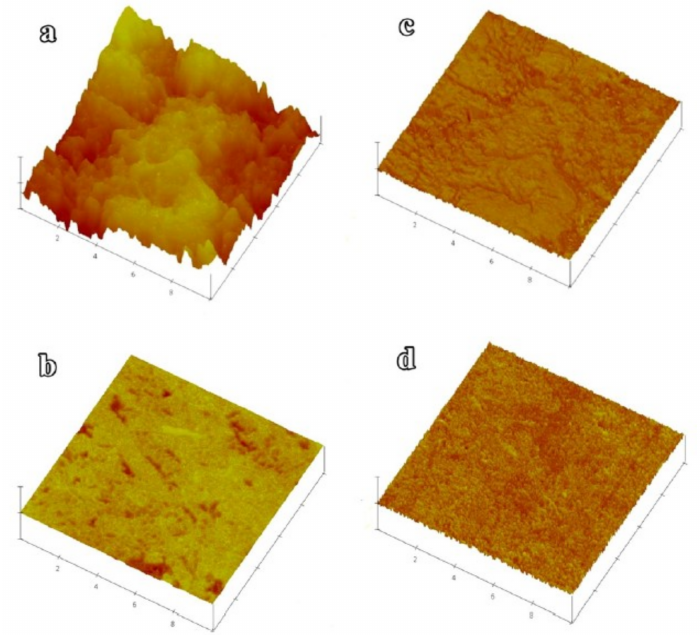
Figure 14. Atomic force microscope images of ( a ) height image of the conventional cement paste, ( b ) height image of the cement paste mixed with nano-TiO 2 , ( c ) phase image of the conventional cement paste, ( d ) phase image of the cement paste mixed with nano-TiO 2 . Reproduced from [131], with permission from American Chemical Society,